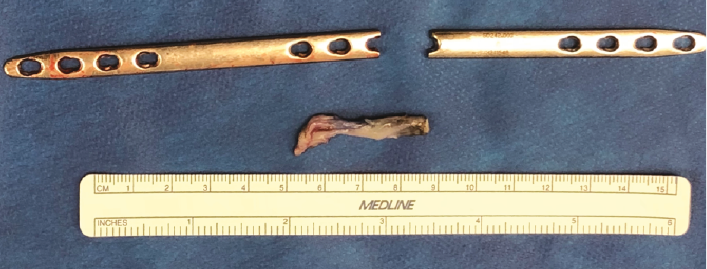
Figure 5: Damaged EPL and bridge plate. The excised portion of the frayed EPL tendon is photographed next to the broken dorsal spanning plate. This damaged portion of the EPL tendon was at the level of the broken plate in situ.